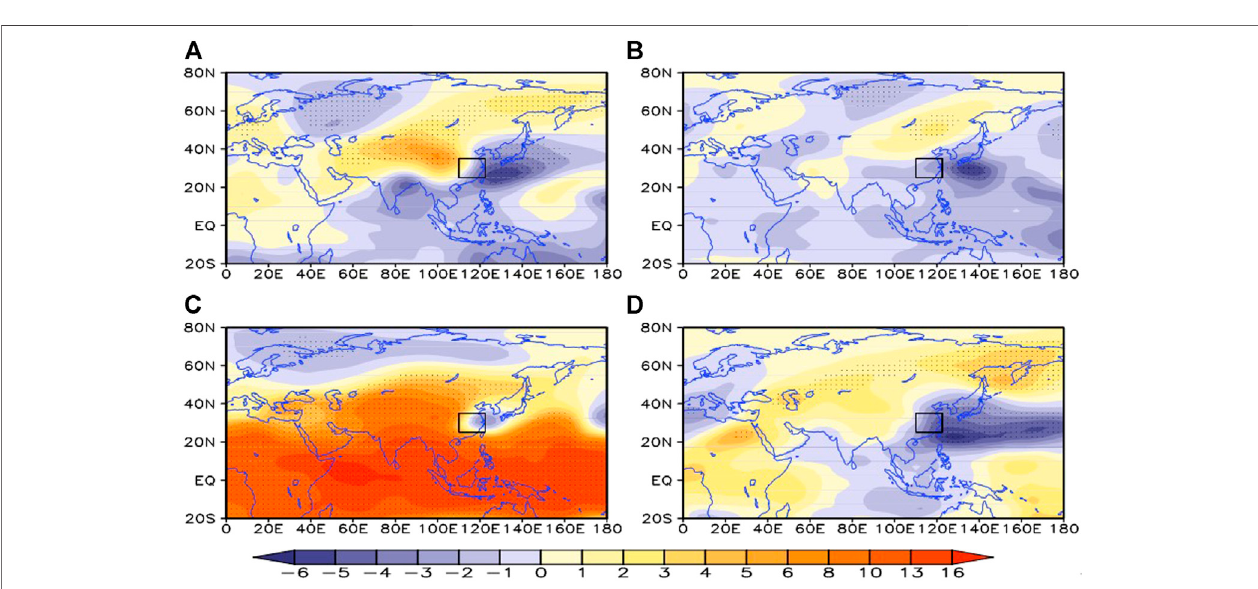
FIGURE 5 | Regression coef fi cient fi eld of the PRR in the MLRYR and the 500 hPa height fi eld in (A) spring, (B) summer, (C) autumn and (D) winter in the MLRYR (units: 10 – 4 /m). The color shading represents the regression coef fi cient, the dotted area represents the 95% signi fi cance test and black rectangular box represents the